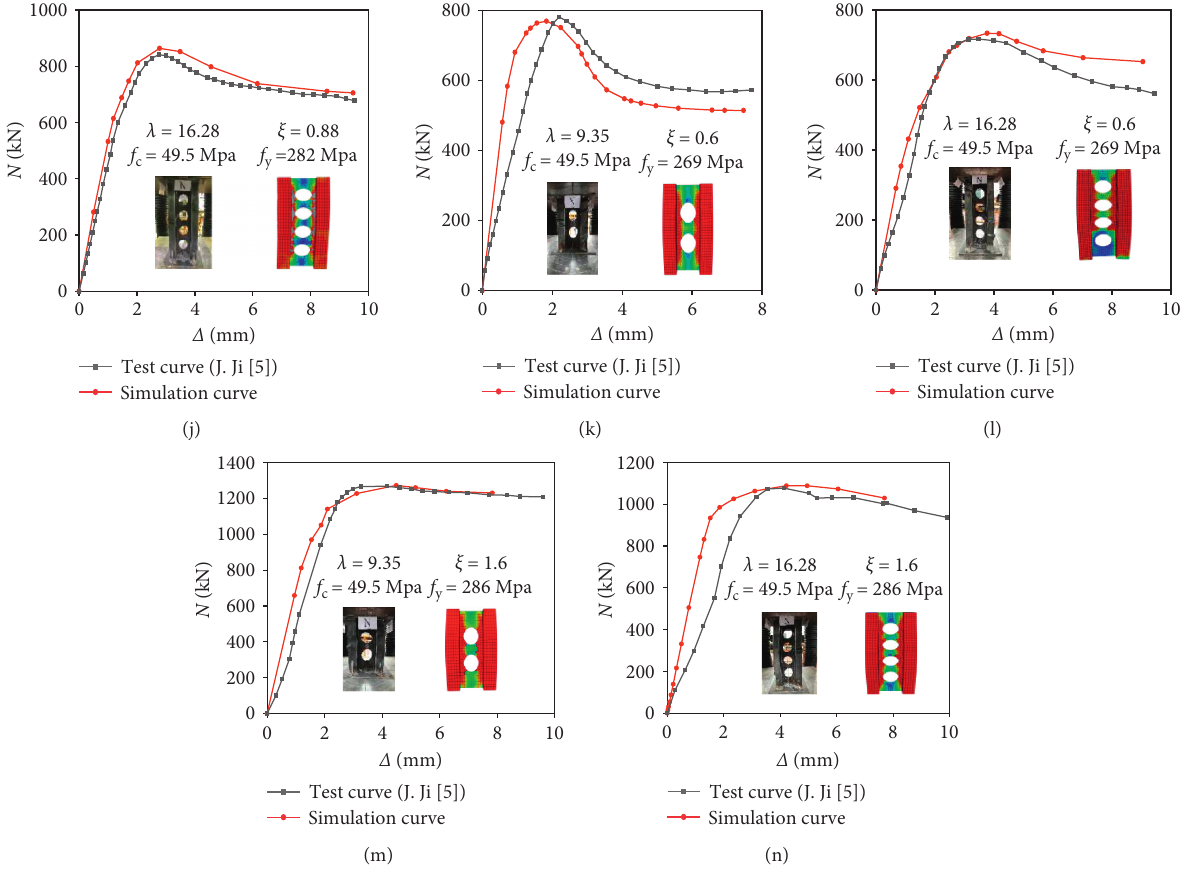
Figure 4: Comparisons of load-displacement curves between simulation and test results. (a) STHCC1. (b) STHCC2. (c) STHCC3. (d) STHCC4. (e) STHCC5. (f) STHCC6. (g) STHCC7. (h) STHCC8. (i) STHCC9. (j) STHCC10. (k) STHCC11. (l) STHCC12. (m) STHCC13. (n) STHCC14.